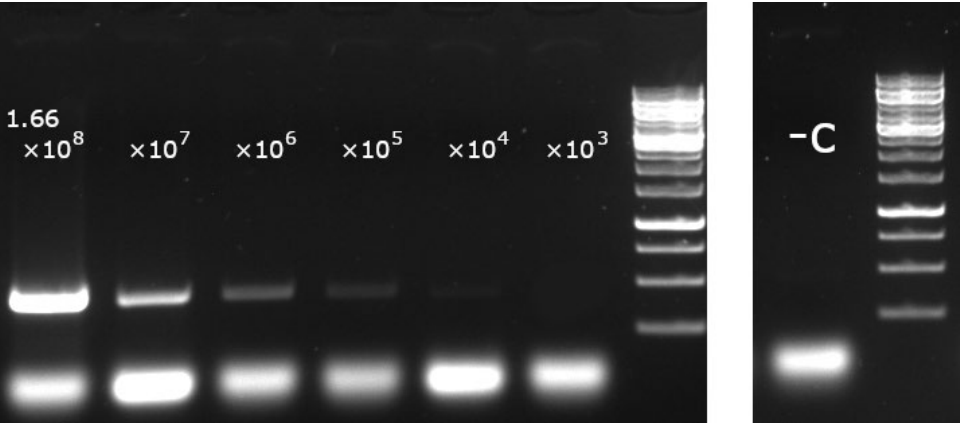
Figure 6. Detection limit of 27a-specific asPCR; 10-fold serially diluted 27a template was amplified by asPCR, and the products were loaded and run on an agarose gel. No visible band can be detected lower than 1.66 × 10 4 copy/reaction at this dilution step.